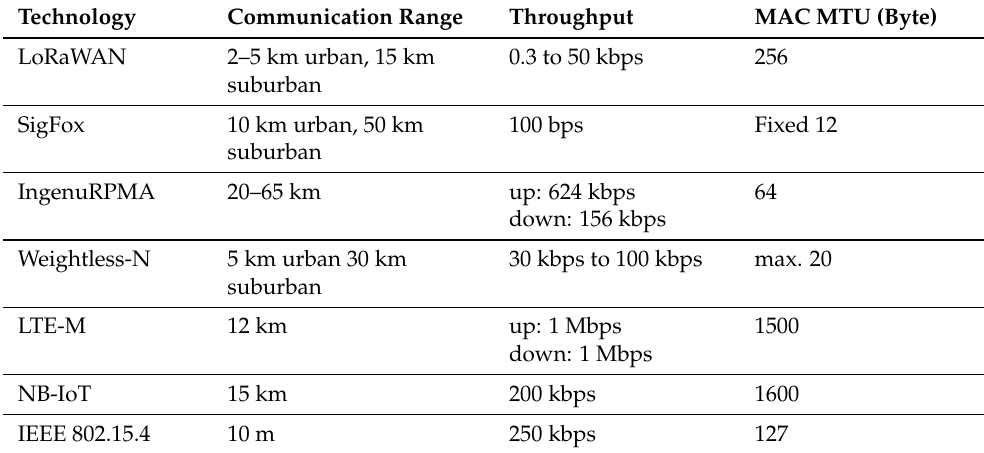
Table 1. Performance